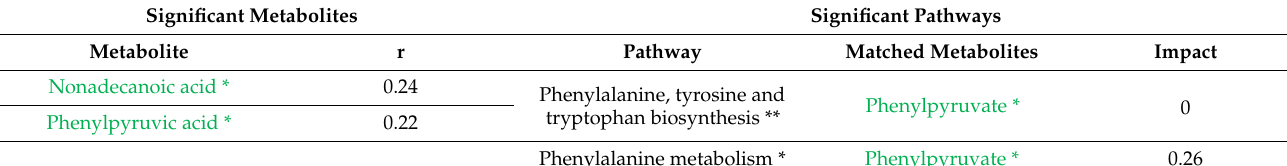
Table 12. Metabolites and their pathways which correlate with the free glutathione redox ratio.